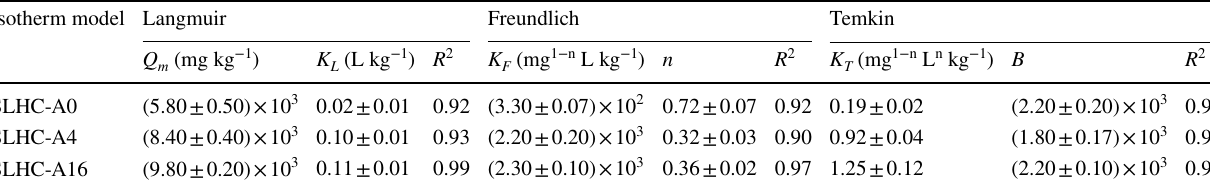
Q m is the theoretical saturation sorption capacity; and representing sorption capacity parameters; n is used to evaluate sorption superiority parameters; K T and B are Temkin sorption